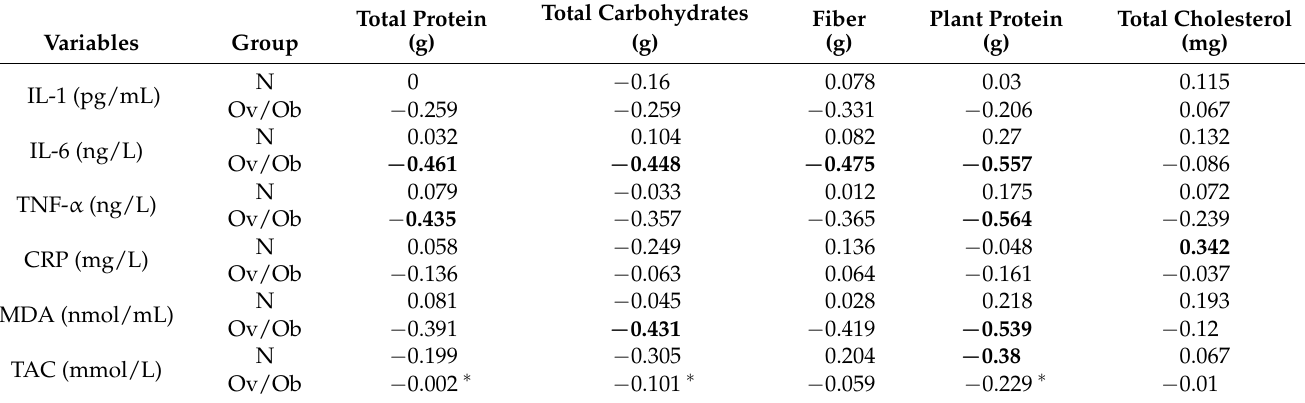
Table 4. Spearman and Pearson’s correlation coefficients (r) between Inflammatory and Oxidative Stress markers and macronutrient intakes in the N group and Ov/Ob